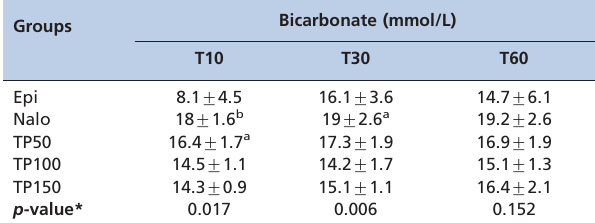
Table 4 - Blood lactate: comparisons of the groups vs. time Groups